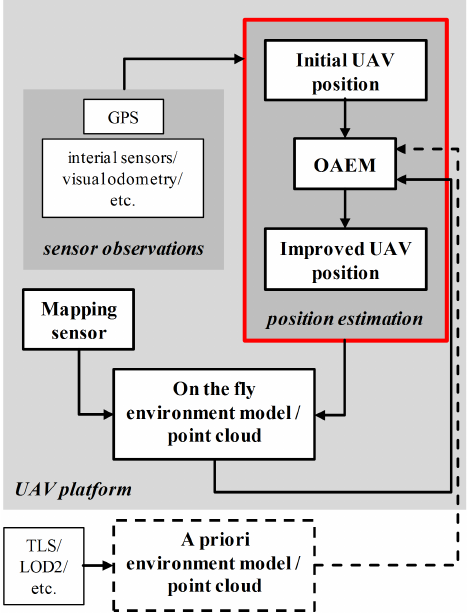
Figure 2. Site-dependent GPS geometry map (colored dots) for a 2D-area between a building (right) and a simplified representation of vegetation (left wall).